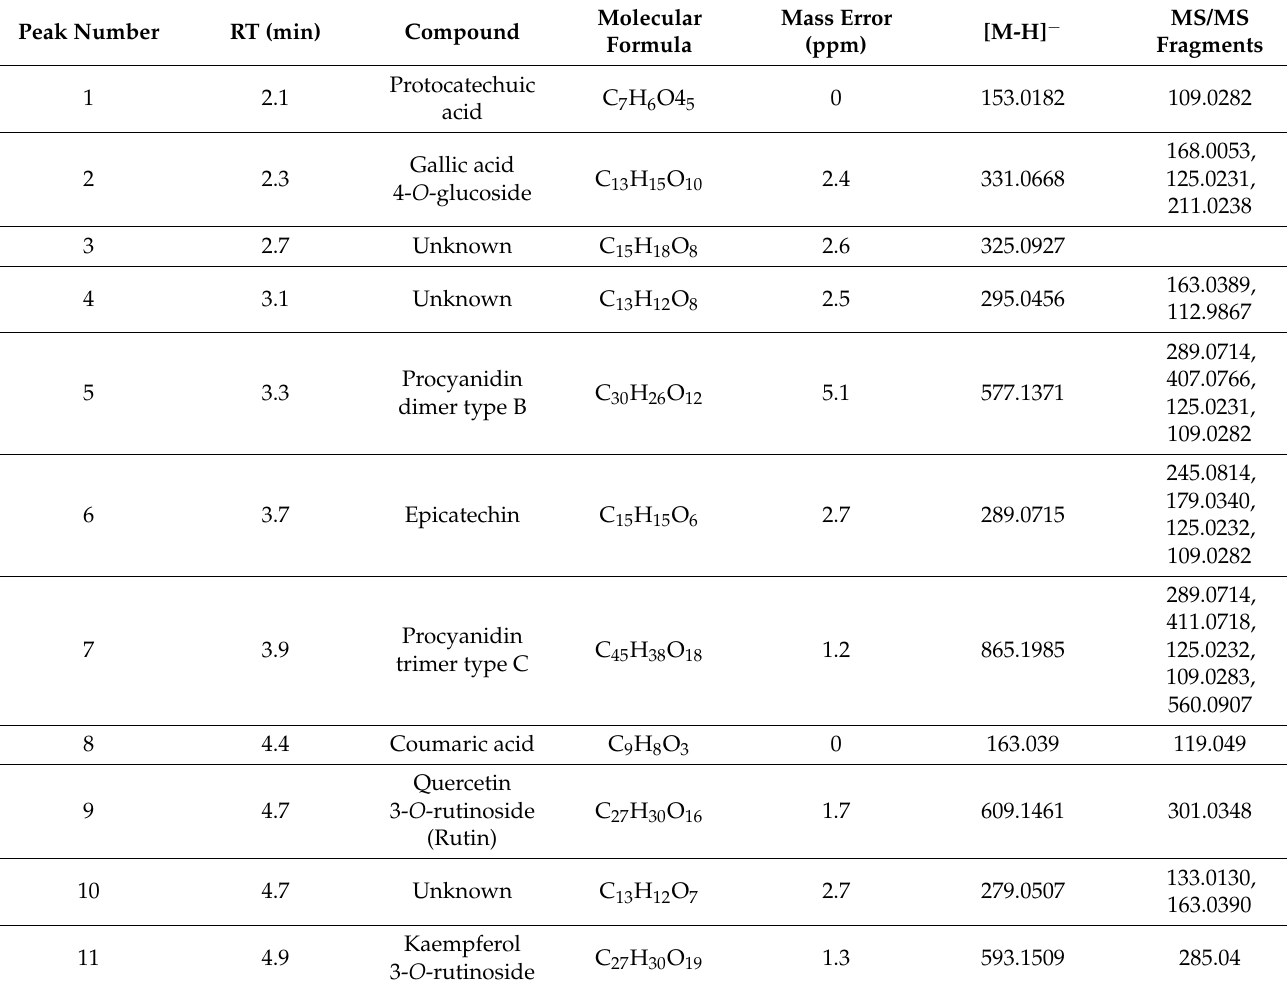
Table 2. Polyphenols identified in D. apetalum plant